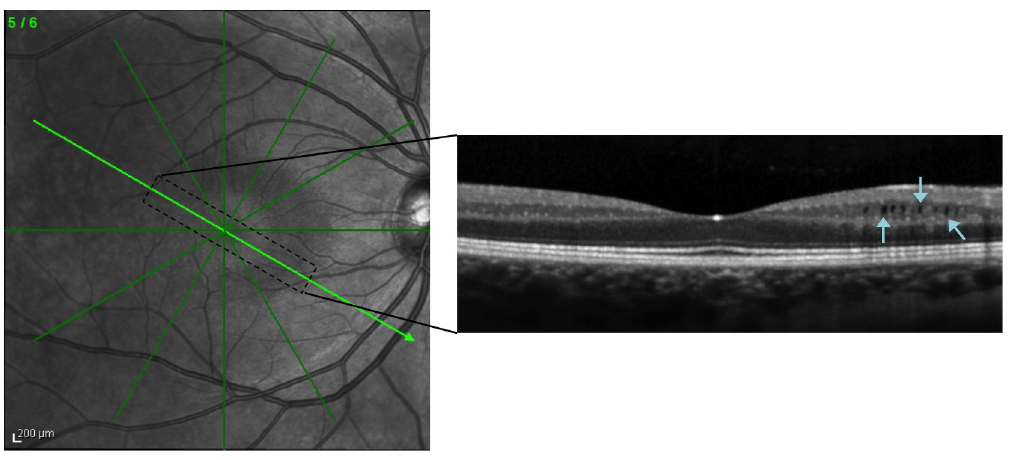
Figure 3. Microcysts in the INL of a patient with a history of acute ON. These microcysts appear more hypo-intense (indicated by the arrows) and are located in the nasal paramacular region but not temporally. doi: 10.1371/journal.pone.0078341.g003 distinctly more hypo-intense on the fundus OCT view. No microcysts were present temporal to the fovea.